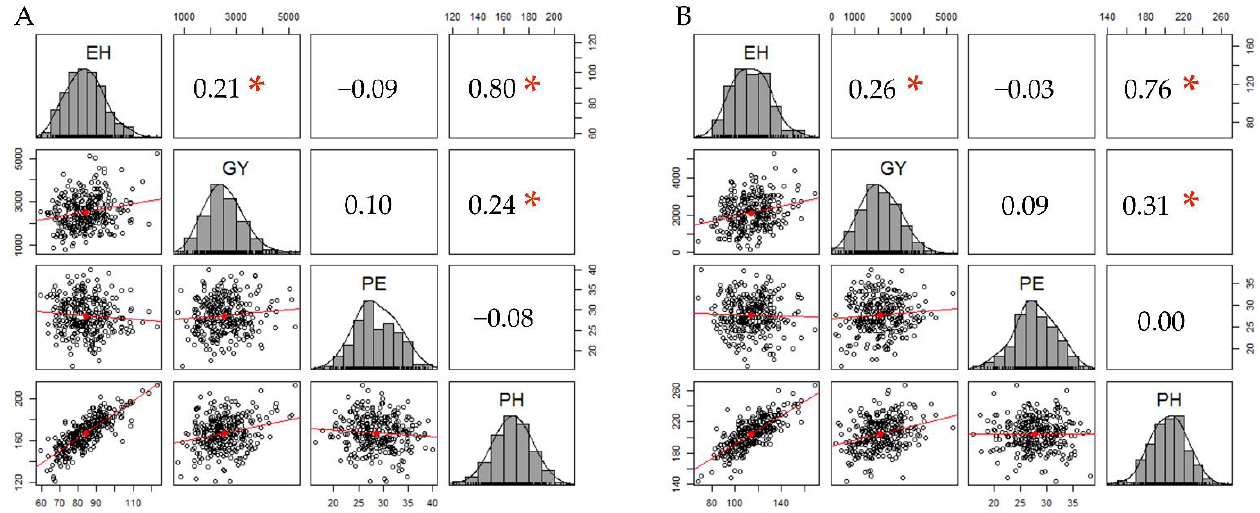
Figure 1. Plot representing phenotypic distribution and correlation for EH (ear height), GY (grain yield), PE (kernel popping expansion), and PH (plant height) traits, evaluated in ( A ) Campos dos Goytacazes (ENV1) and ( B ) Itaocara (ENV2). The diagonal line of the plot shows the histograms and the distribution of the observed phenotypes values. The lower off-diagonal is the scatterplot between the four traits, whereas the upper off-diagonal represents the correlation value between traits. Significant correlations ( p -value < 0.001) are tagged with an asterisk.